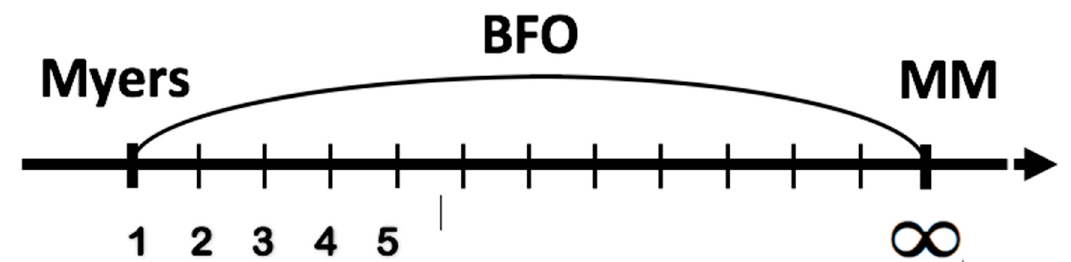
Figure 2. Myers result describes one-year company, Modigliani–Miller theory (MM) corresponds to perpetuity limit, while Brusov–Filatova–Orekhova (BFO) theory fills the whole numeric axis (from n = 1 up to perpetuity limit n = ∞).